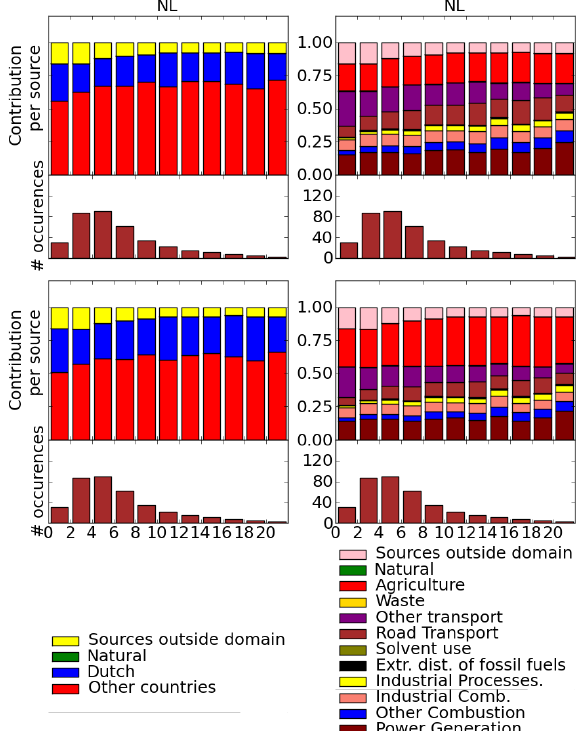
Fig. 8. Contributions of Dutch, foreign, natural and boundary sources (left) and anthropogenic source sectors (right) to nitrate concentrations averaged over the Netherlands. The attribution is shown as a function of nitrate levels on the x-axis. The upper panels present the default source attribution. The lower panels present the source attribution corrected for the ammonium nitrate assumption